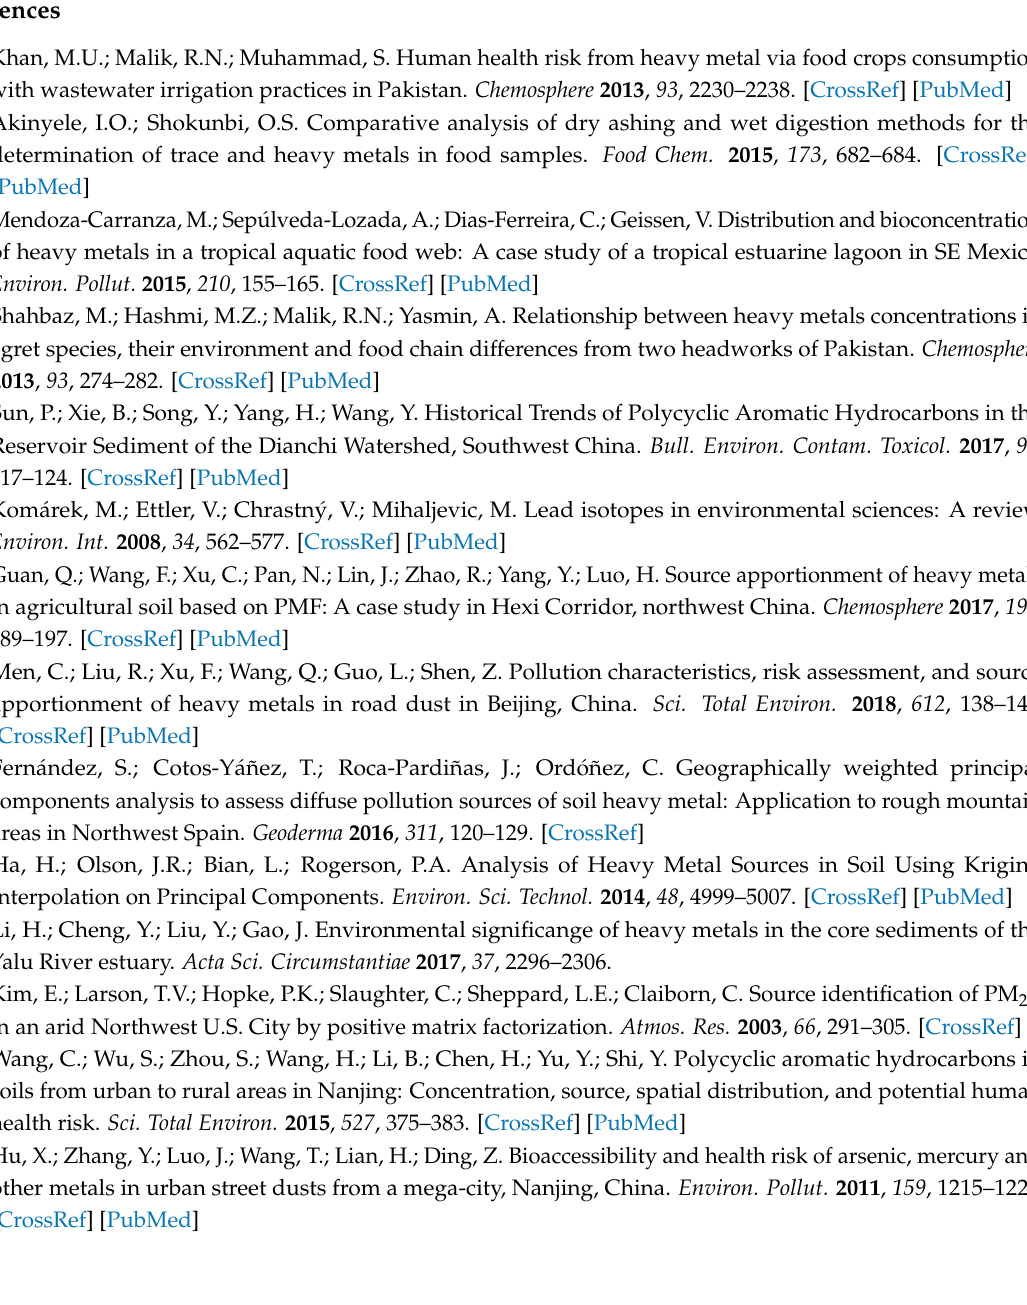
s1, Table S1: Operating parameters of ICP-MS (ELAN 9000, Perkin-Elmer SCIEX) for the determination of element concentrations, Table S2: Operating parameters of ICP-OES (Optima 5300DV, Perkin-Elmer SCIEX) for the determination of elemental concentrations, Table S3: Uncertainty analysis of the model, Table S4: Detection limit, Quantification limit and Recovery rate for the heavy metals, Table S5: Factor Profiles (% of factor